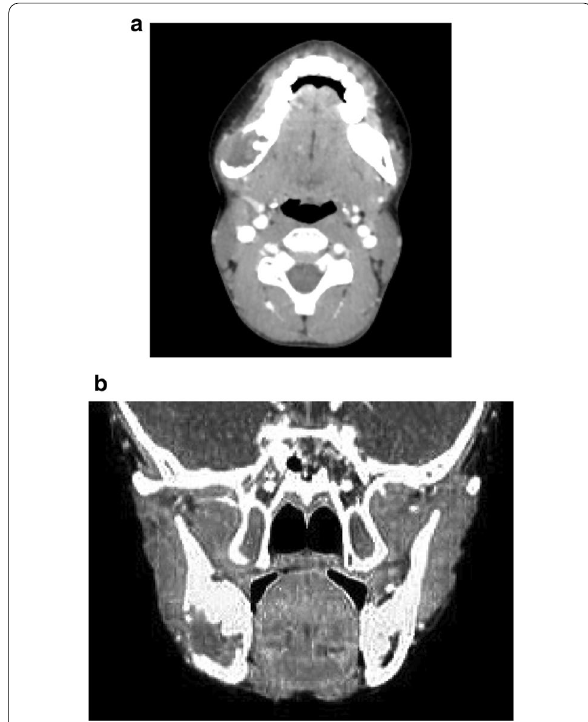
Fig. 4 a Axial CECT image showing lytic lesion with expansion of buccal cortex and erosion of outer table at angle of mandible and abnormal enhancing soft tissue within the lytic cavity without showing any periosteal reaction. b Coronal CECT image showing the center of the lytic lesion